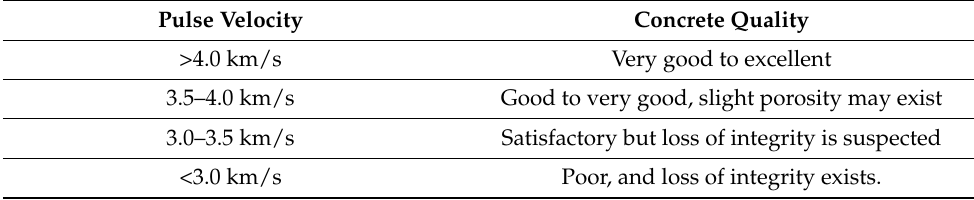
Table 3. Quality of concrete based on UPV value (ASTM C597 2016).